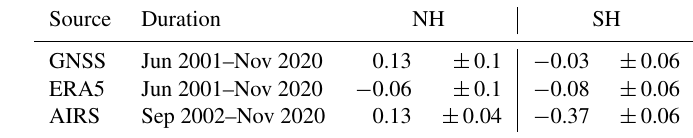
Table 3. Tropical belt expansion and contraction rates based on an objective criterion.